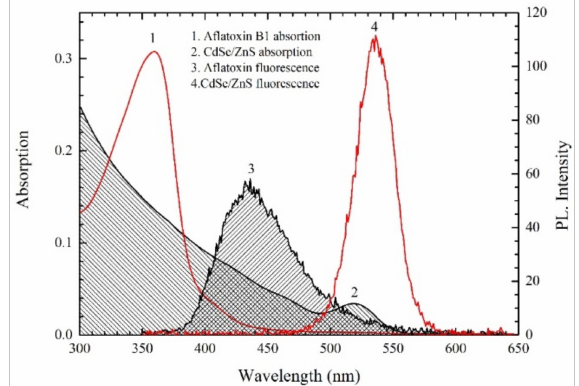
Figure 1. The absorption and fluorescence spectra of AFB1 and CdSe / ZnS QDs in aqueous solution. The overlap between AFB1 fluorescence and CdSe / ZnS absorption is shown by cross-line